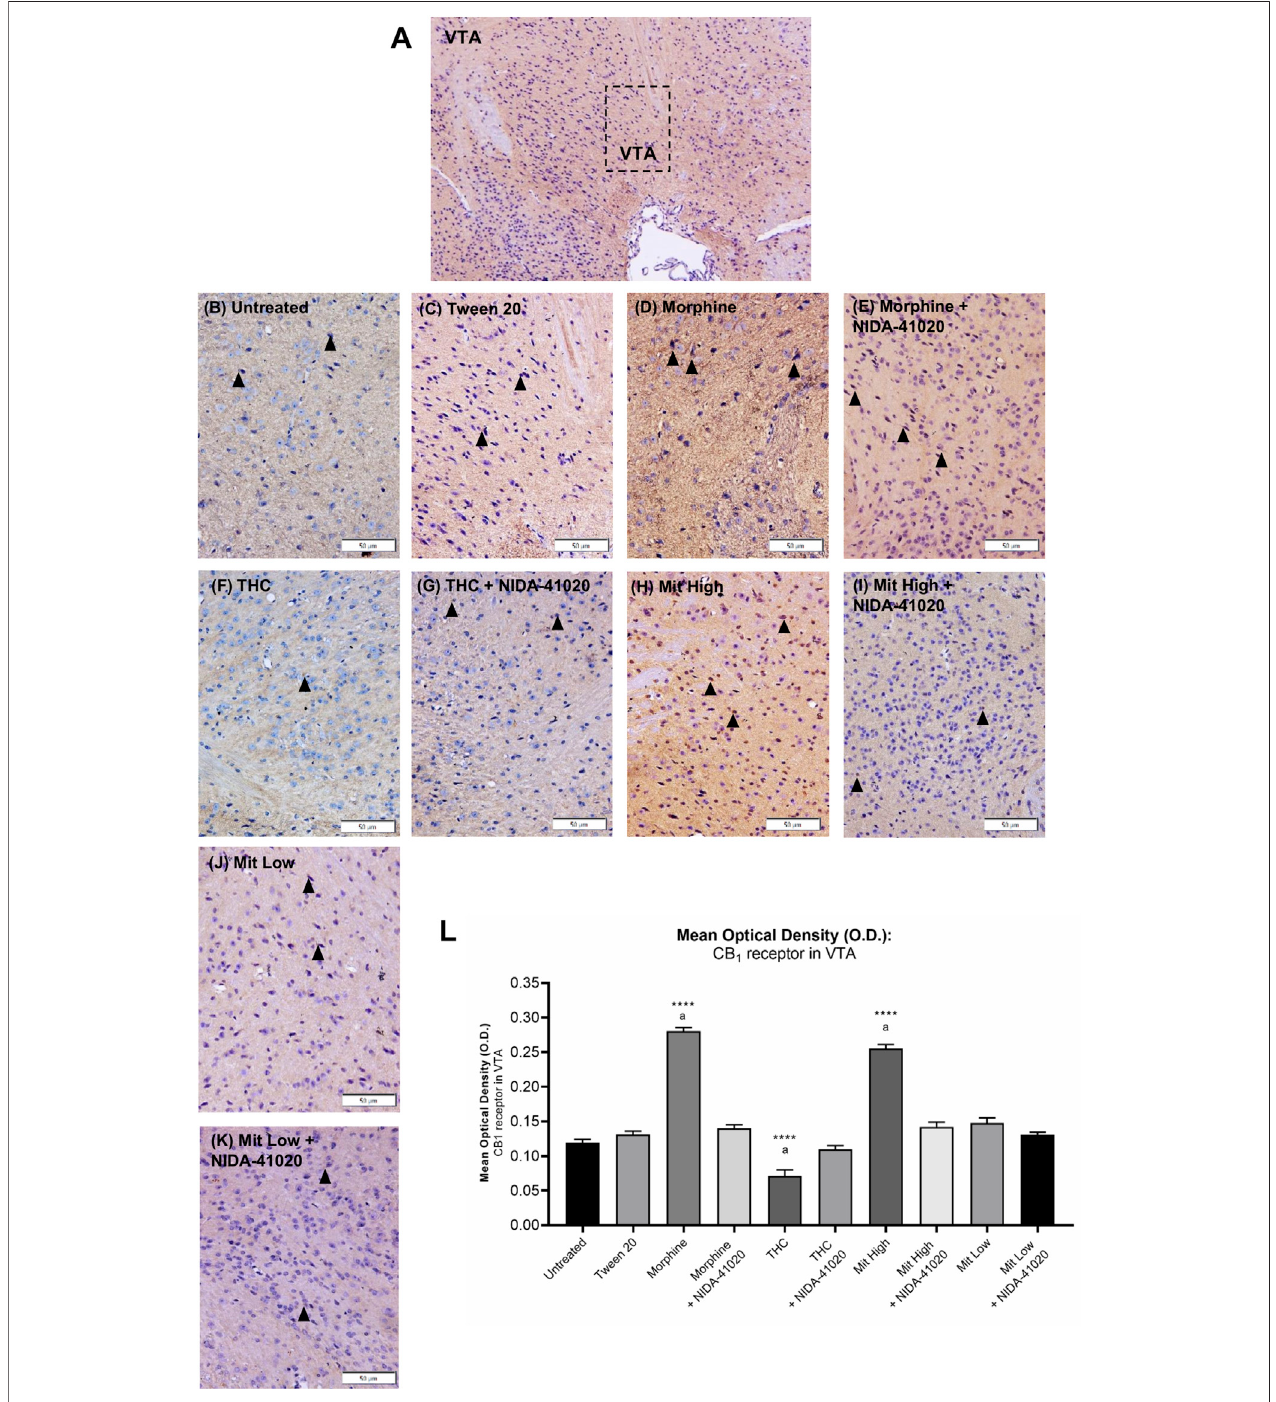
FIGURE7| EffectsofdruginterventiononCB 1 receptorstainingin (A) miceVTA( × 100magni fi cation).Themicrographsrepresent (B) untreated, (C) Tween20, (D) morphine, (E) morphine+NIDA-41020, (F) THC, (G) THC+NIDA-41020, (H) high-dosemitragynine, (I) high-dosemitragynine+NIDA-41020, (J) low-dosemitragynine, and (K) low-dose mitragynine + NIDA-41020 groups at × 400 magni fi cation. Arrowheads indicate CB 1 immunoreactive neurons and the surrounding fi bers. (L) Densitometric analysis are shown as mean + SEM of 15 replicates per group. **** p < 0.0001 vs Tween 20; a: p < 0.05 vs drug + NIDA-41020 groups (one-way ANOVA followed by post-hoc Tukey test). Bars (cid:1) 50